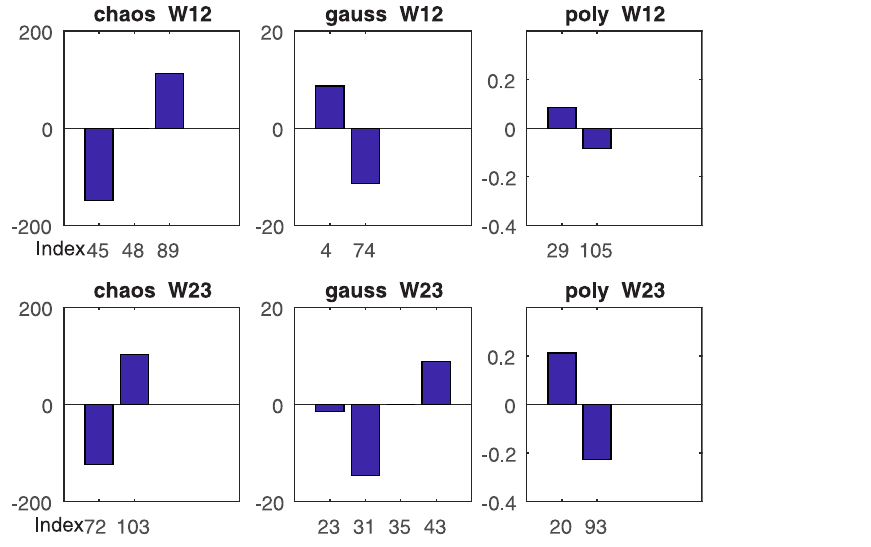
Fig 12. Comparison of two typical RVM training weights of three kernel functions.